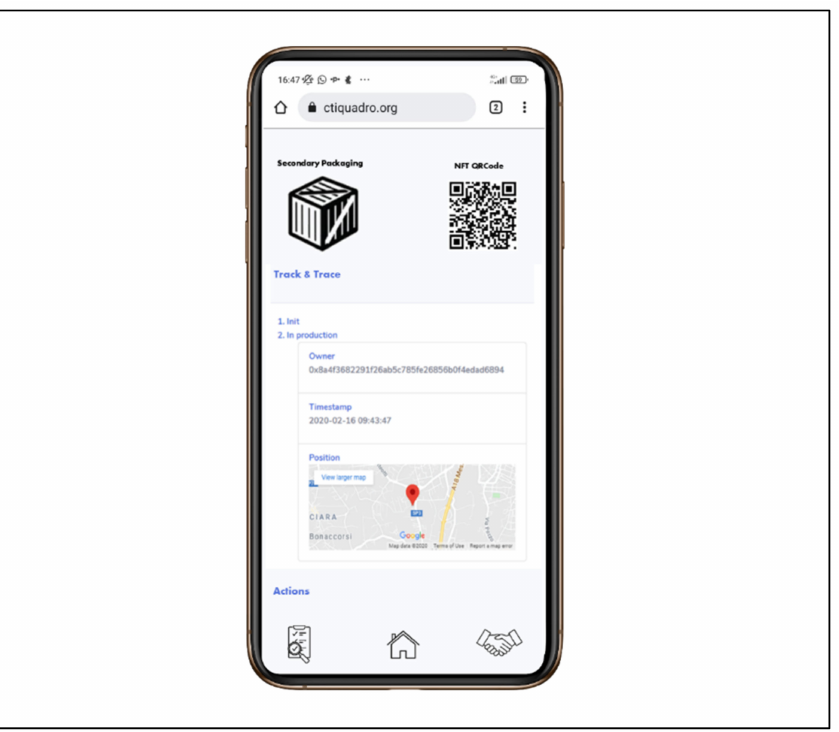
Figure 11. Prototype of the DAPP running within the VeChain Thor blockchain test network.